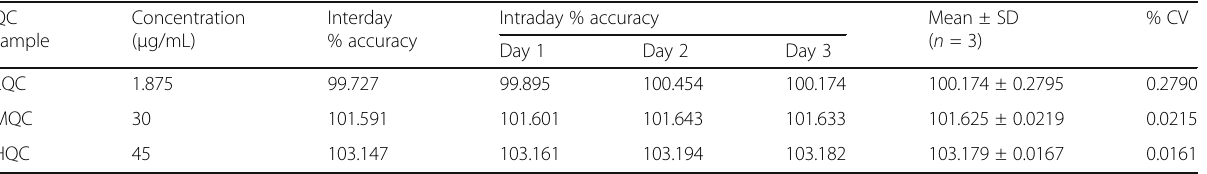
Table 5 Accuracy parameters for developed bioanalytical method QC sample